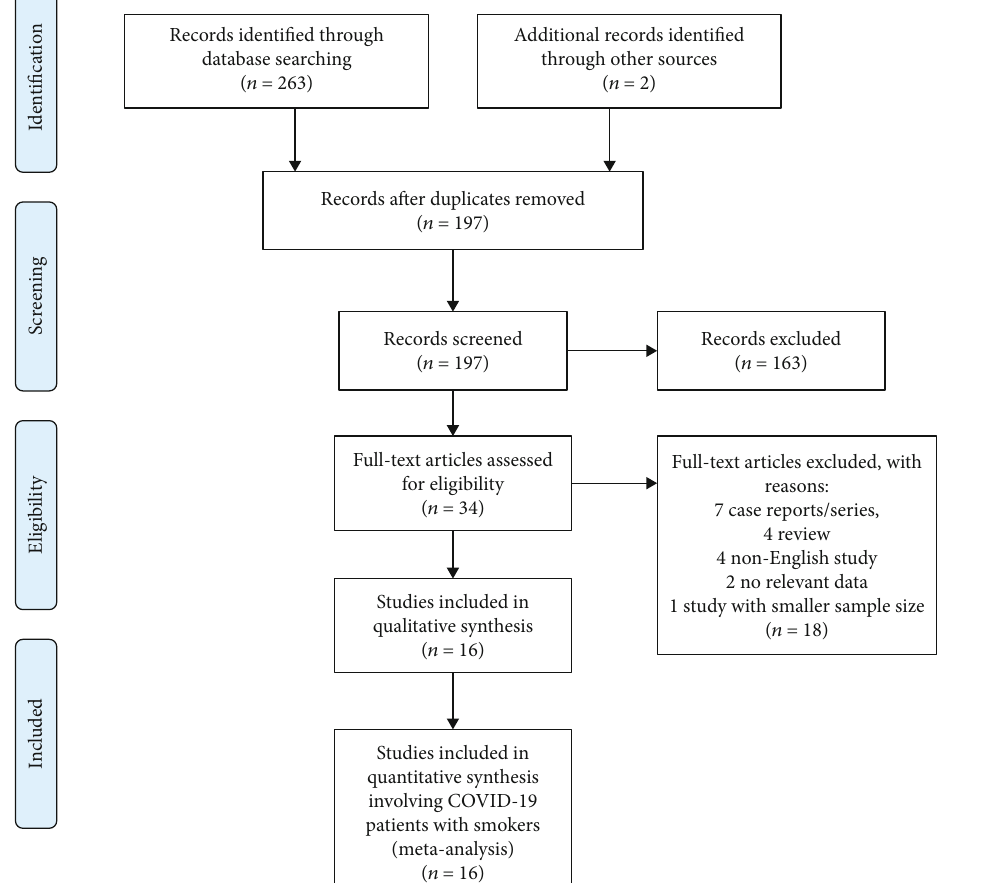
Figure 1: PRISMA fl ow diagram of study selection